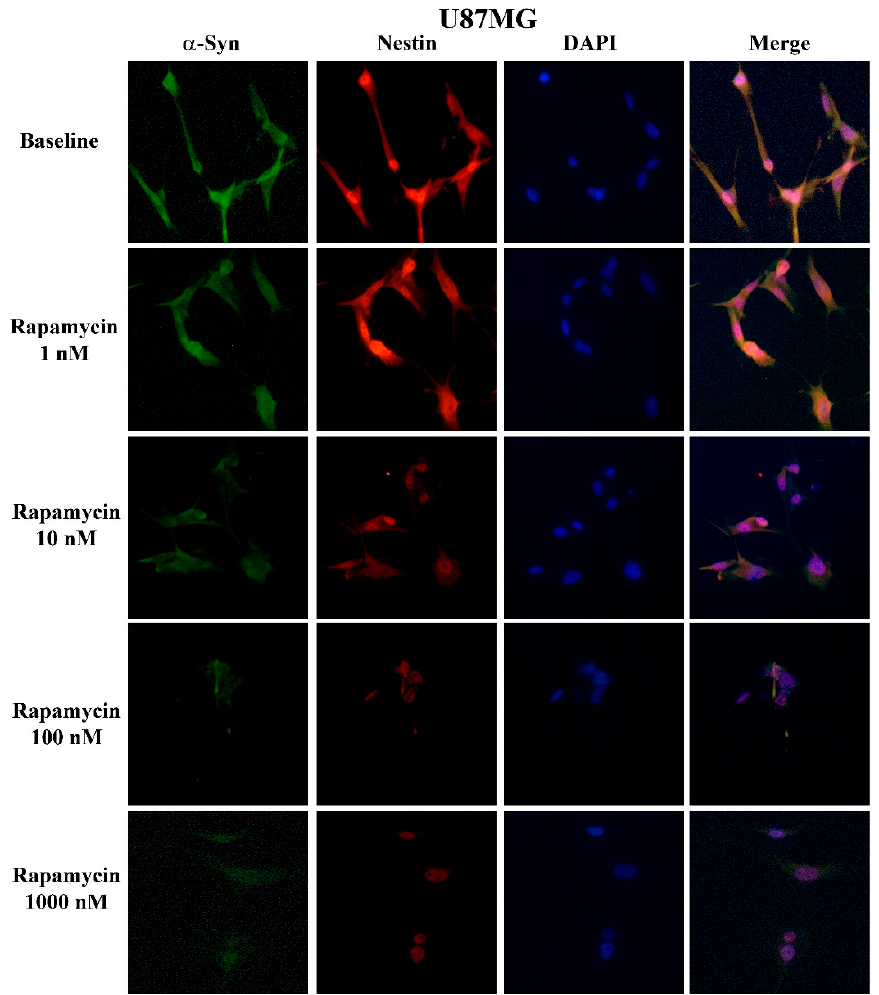
Figure 7. Rapamycin dose-dependently reduces α -syn and nestin immuno-fluorescence in GBM cells to an amount which is similar to baseline astrocytes (representative pictures). Representative pictures show immuno-fluorescence for α -syn (green), and nestin (red) within astrocytes and GBM cells, both in baseline conditions and following rapamycin administration. Each cell nucleus is visualized by using DAPI (blue), merging between antigens is shown as pink. Scale bar = 24 μ m.